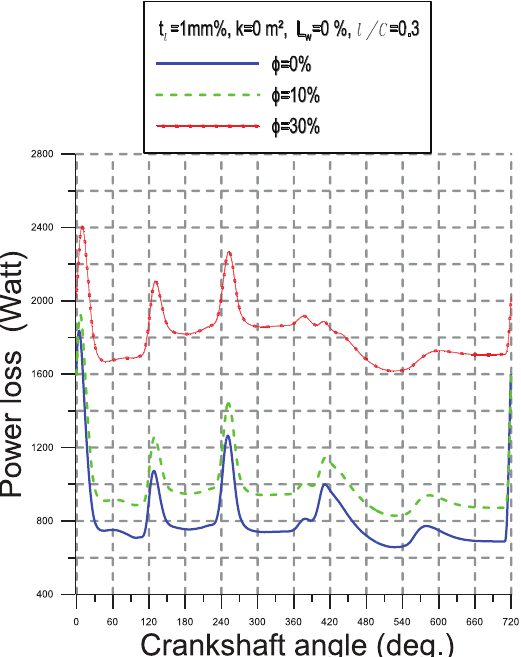
Fig. 22. Effects of the nanoparticles concentration parameter on power loss over an engine